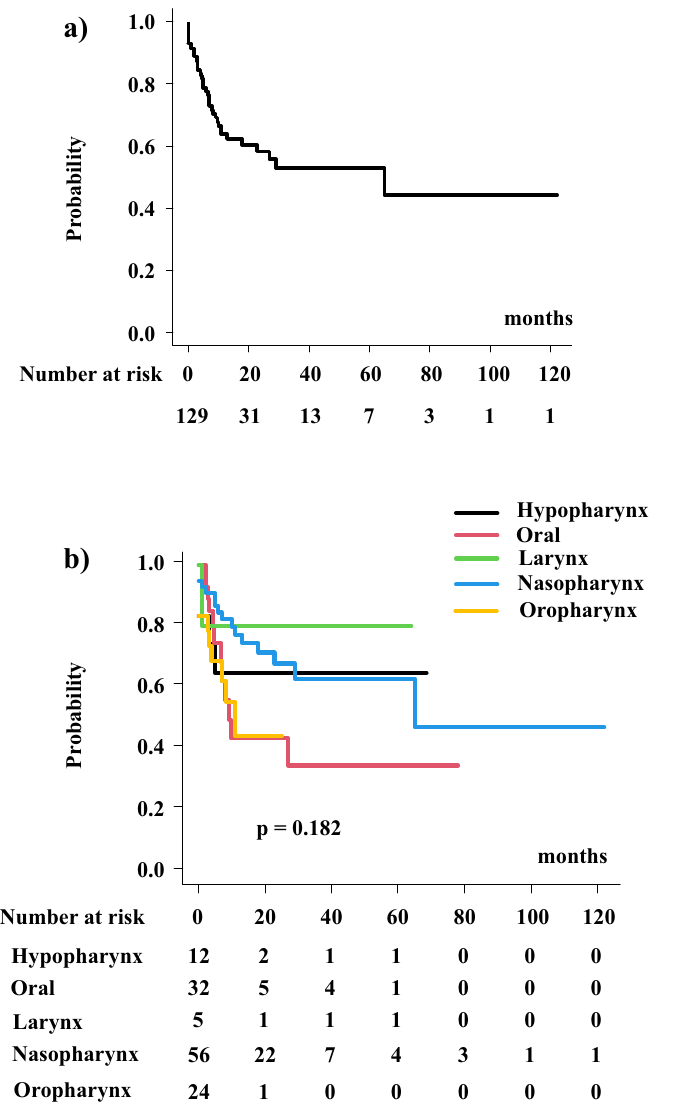
Figure 2. Local control rate. ( a ) Local control rate in the entire population. ( b ) Local control rate according to primary sites. ( c ) Local control rate between nasopharyngeal cancer and